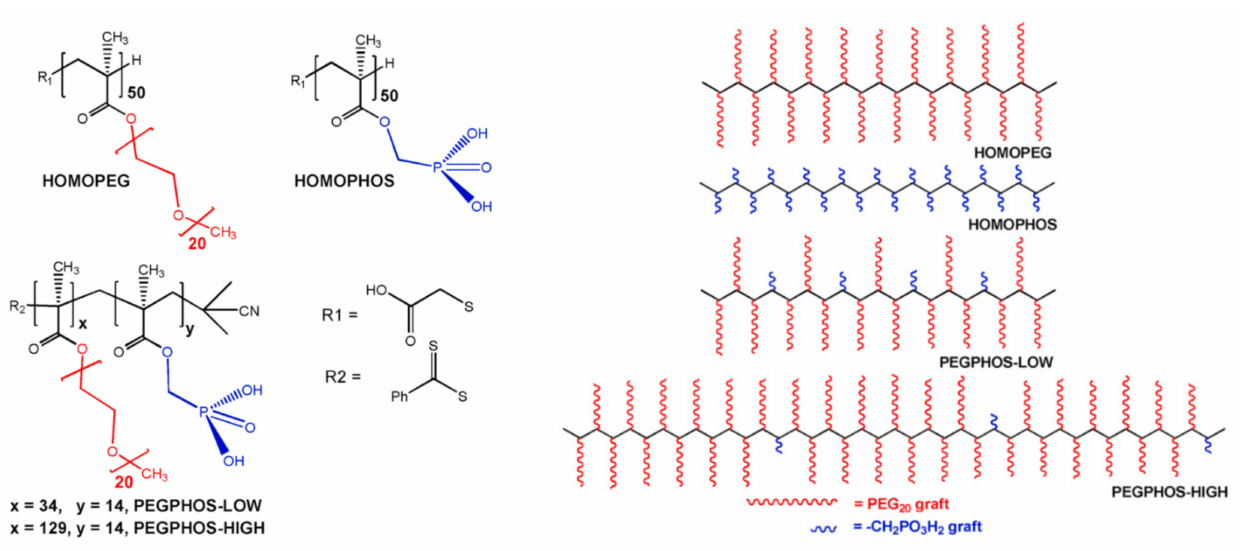
Figure 8. Schematic structures of methacrylate-based polymeric scale inhibitors with phosphonate and PEG grafts